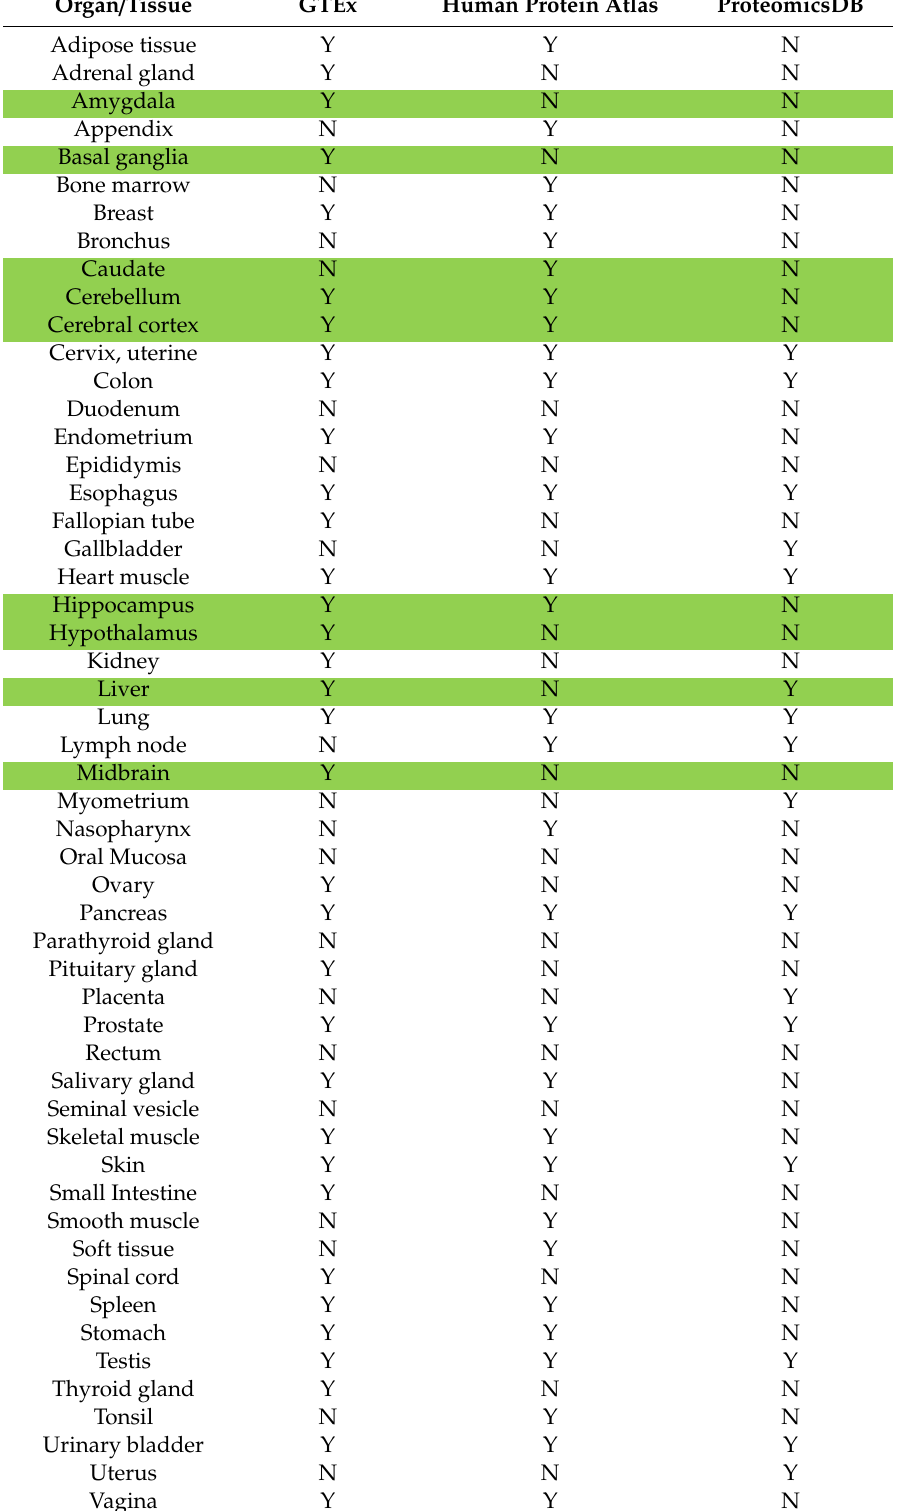
Table 6. Reported IL-33 protein expression in humans in the GTEx, Human Protein Atlas, and ProteomicsDB